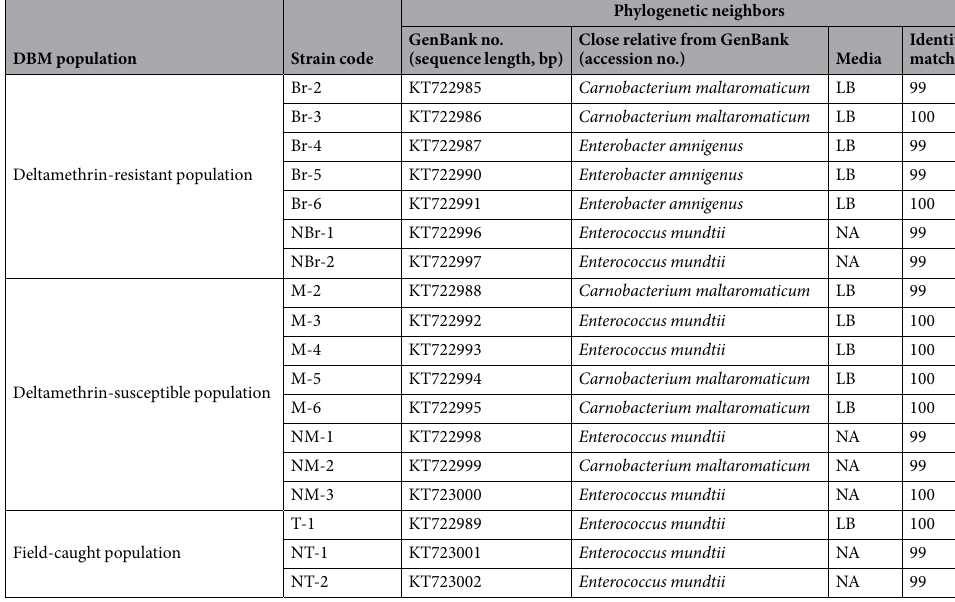
Table 2. Molecular identification of the larval gut bacteria isolated from the midgut of the diamondback moth, Plutella xylostella